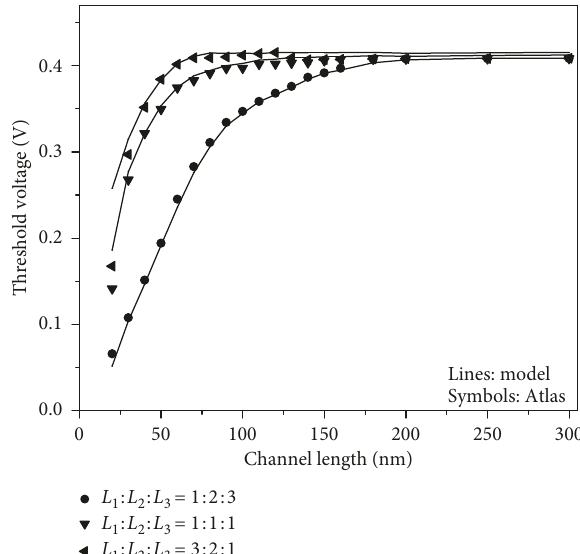
Figure 3: Threshold voltage for different ratios of control gate and screen gates of TMG Re-S/D SOI